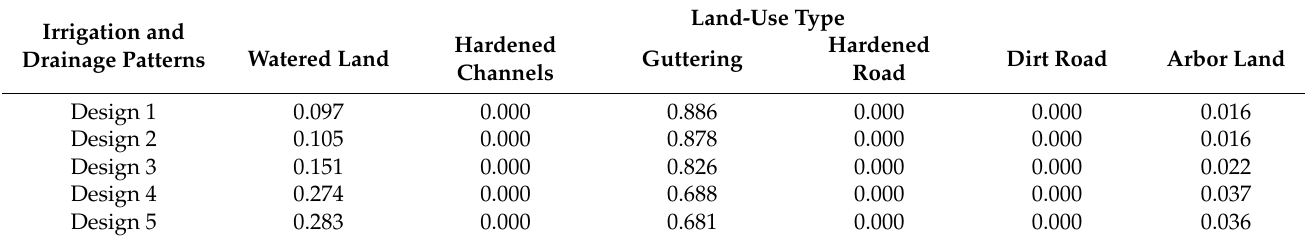
Table 7. Changes in the project area’s sensitivity indices (CS) of ecosystem service values under five different forms of irrigation and drainage.